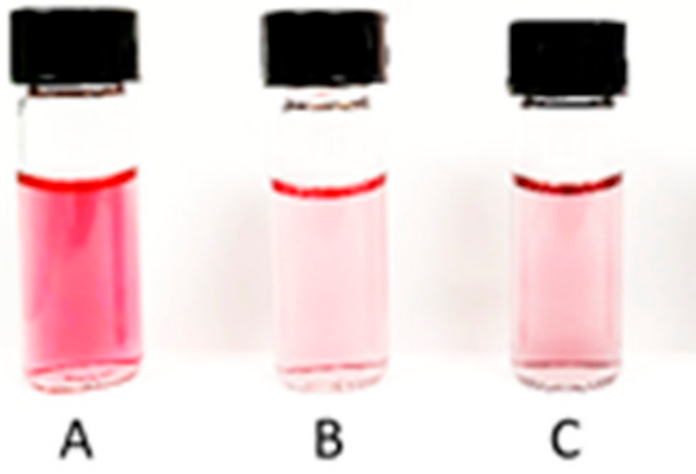
Figure 2. Digital image of synthesized AuNPs ( A ), Au@Pt–monolayer ( B ) and Au@Pt–multilayer